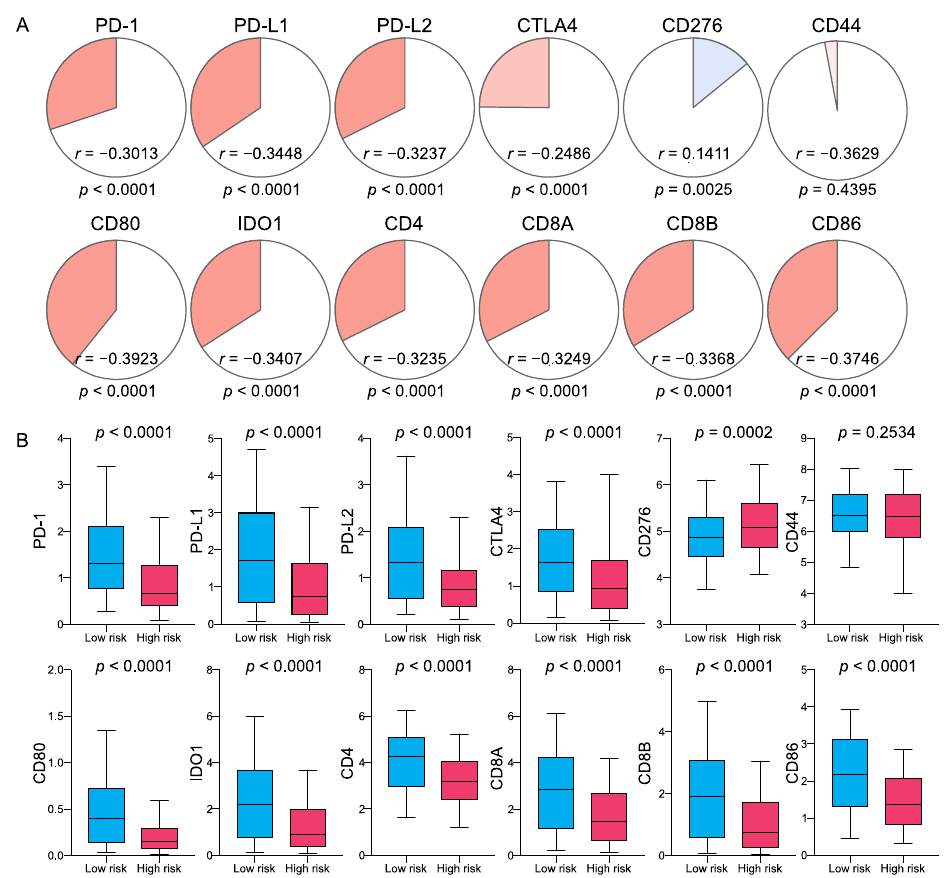
Figure 7. Correlation of FRG DNA methylation signature with immune checkpoint-related genes (ICGs): ( A ) Correlation analysis. The circle symbols represent Spearman’s correlation coefficients, and p -values are shown below. Blue indicates positive correlation and red indicates negative correlation. ( B ) Differences in the expressions of ICGs between low- and high-risk groups.